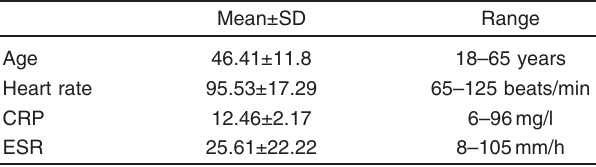
Table 1 Quantitative variables of the studied group